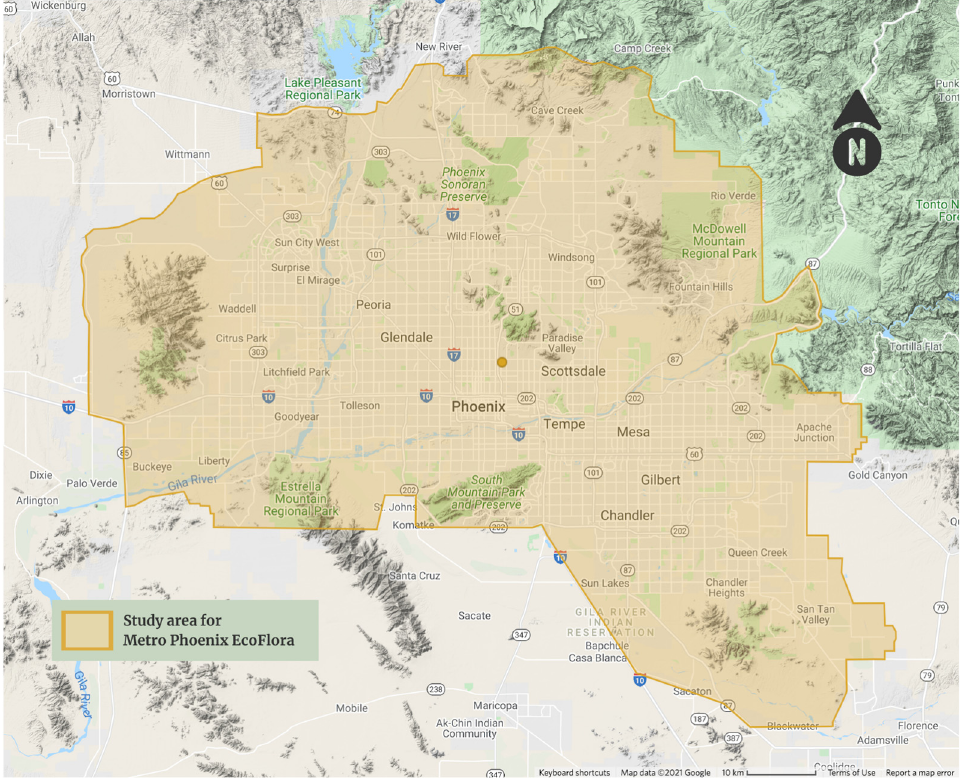
Figure 1. Study area for the Metro Phoenix EcoFlora project created with iNaturalist, using Google Maps